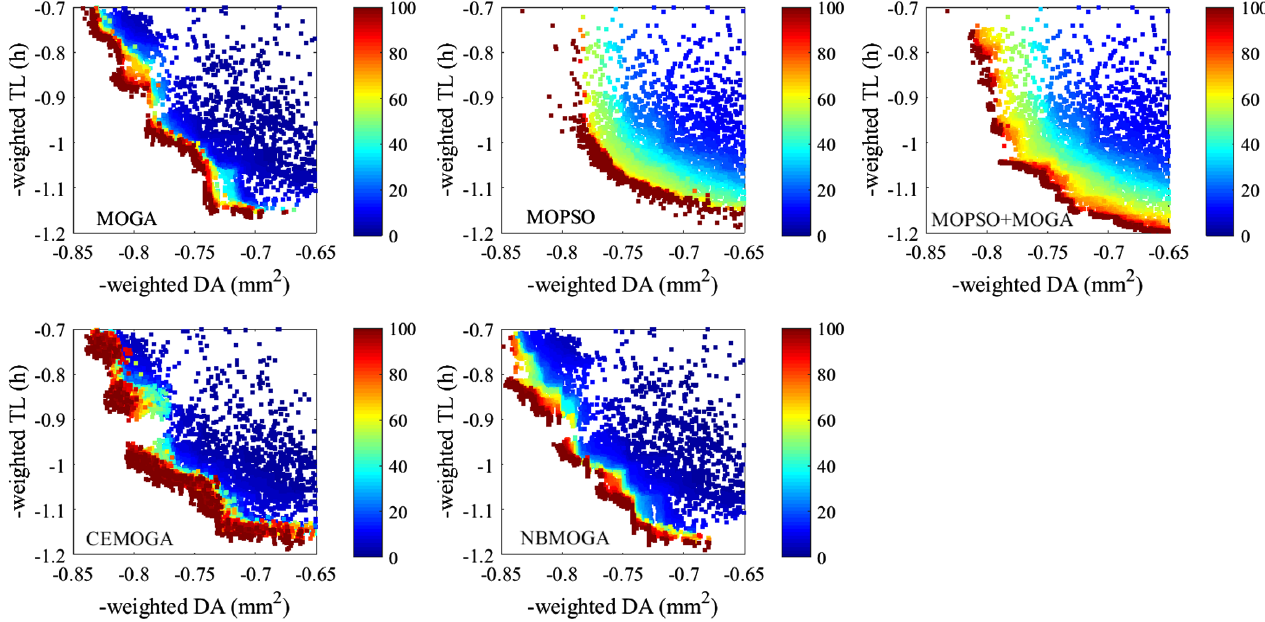
FIG. 10. Evolutions of population for optimizing DA and TL. The color from blue to red represents the index of generation from 1 to